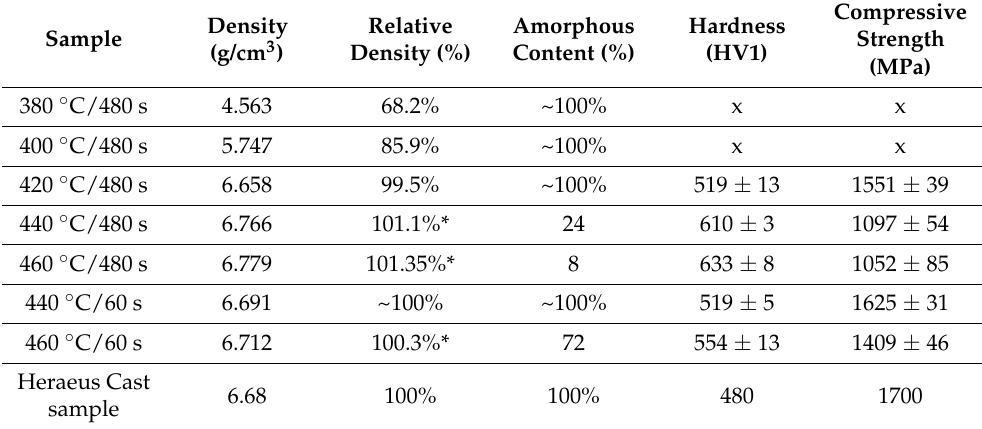
Table 2. Physical and mechanical properties of samples.